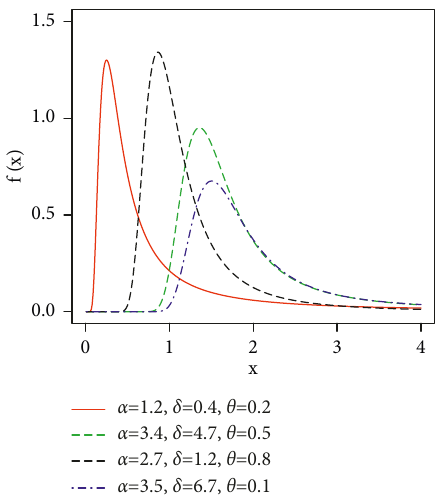
Figure 4: Some possible PDF plots of the NG-IW